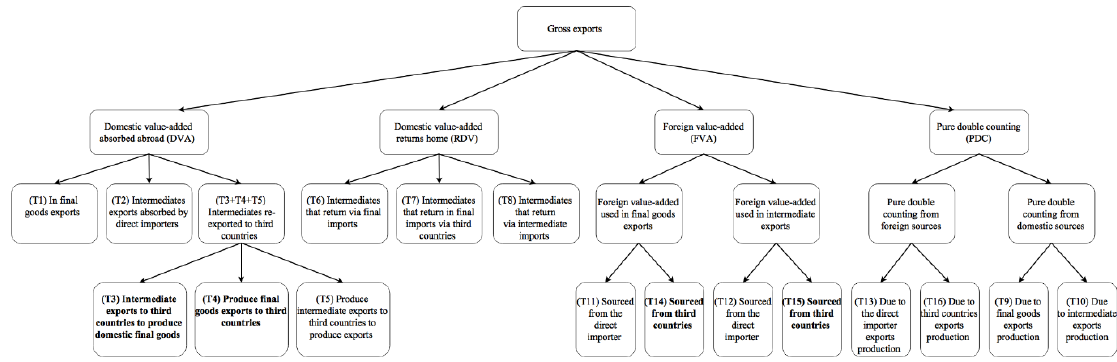
Fig. A1.1. Decomposition of gross exports. Gross exports are entirely decomposed into 16 non-overlapping components (T1 to T16). Quoted from Wang et al.